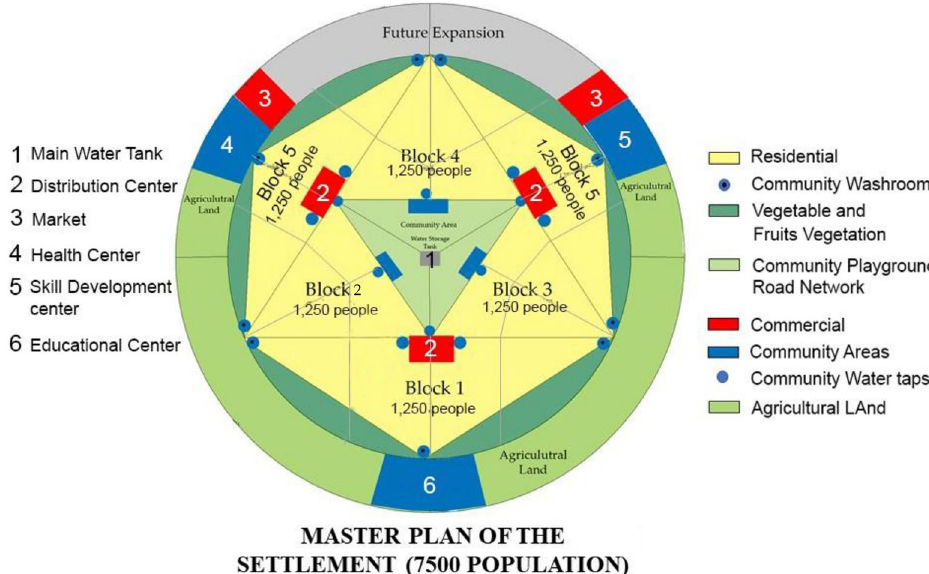
Fig. 6 Master plan of the settlement (7500 population)